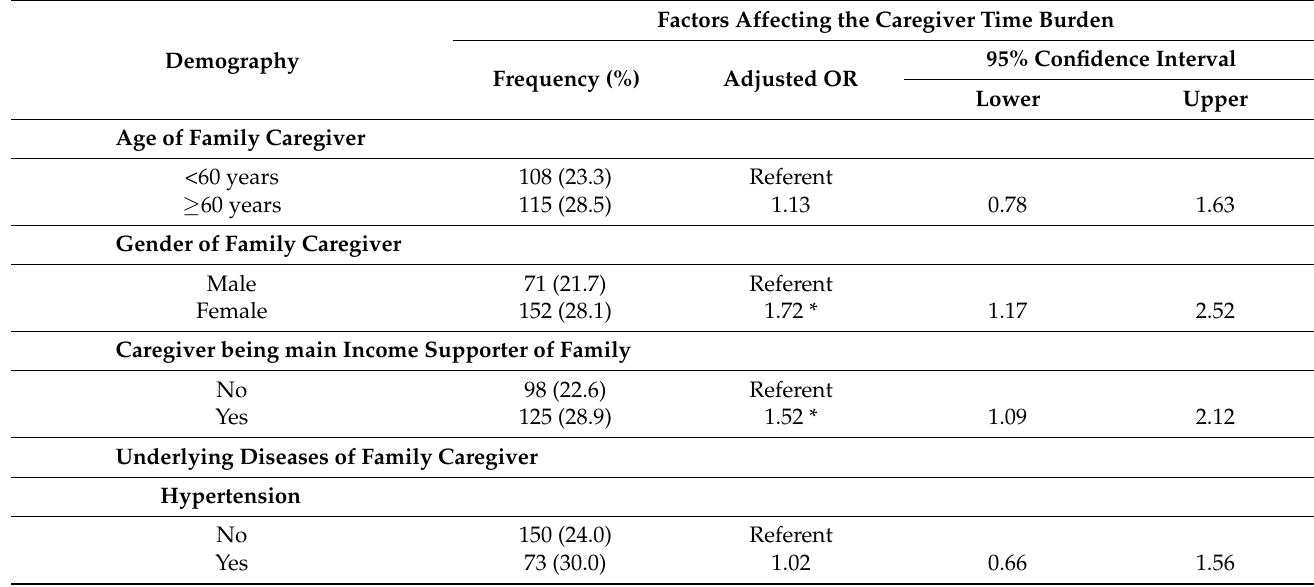
Table 4. Factors affecting the time-dependence burden of family caregivers, Maehia subdistrict, Chiang Mai, Thailand,